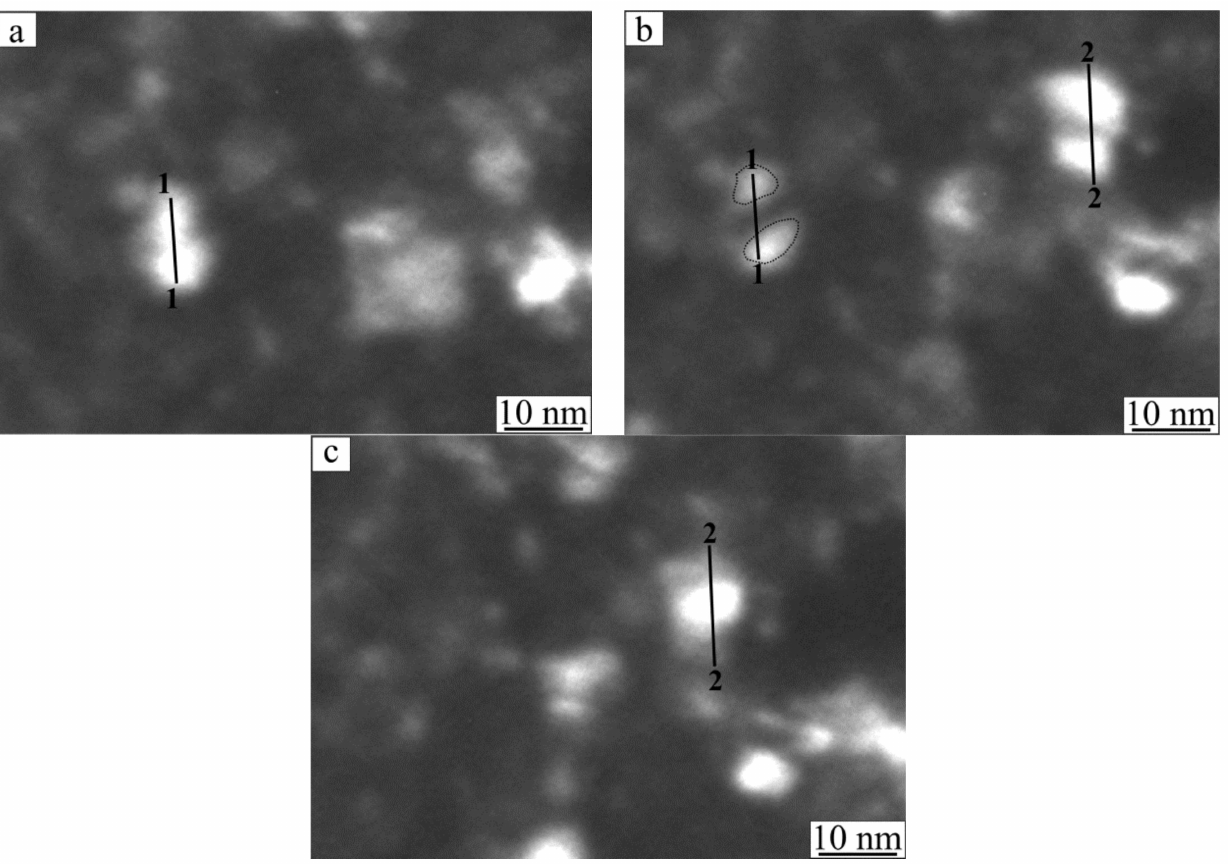
Figure 11. Dark-field images of displacement of bending extinction contours in crystals that illustrated the nonuniformity and multi-dimensional character of the orientation switch for reflecting planes, ( a ) sample tilt angle 0 ◦ , ( b ) sample tilt angle 0.5 ◦ , ( c ) sample tilt angle 1 ◦ (see explanation in